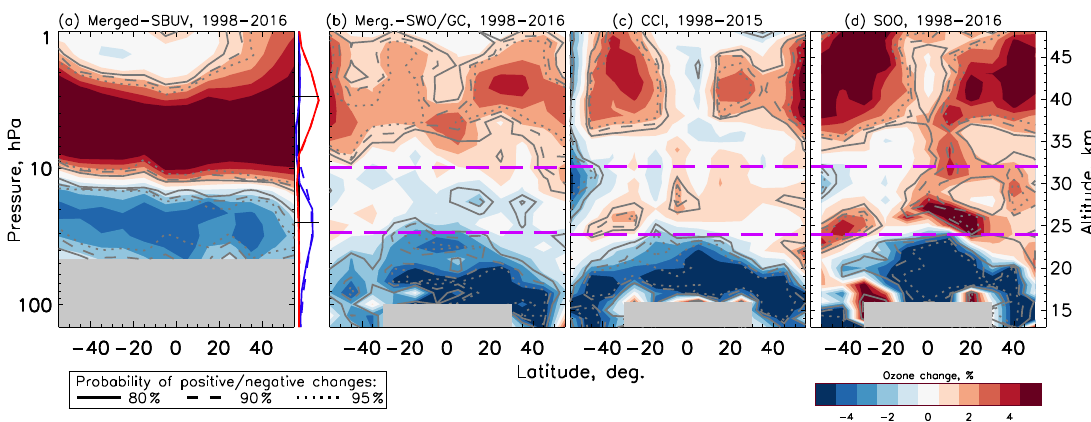
Figure 1. Zonally averaged change in ozone between 1998 and 2016. From (a–d) the Merged-SBUV, Merged-SWOOSH/GOZCARDS, SAGE-II/CCI/OMPS (CCI), and SAGE-II/OSIRIS/OMPS (SOO) composites. Red represents increases, blue decreases (%; see right legend). Contours represent probability levels of positive or negative changes (see left legend). Grey shaded regions represent unavailable data. Pink dashed lines delimit regions integrated into partial ozone columns in Fig. 2 (and Figs. S3, S4, S6, S9, and S10). To the right of Merged- SBUV are the instrument observing profiles centred at 3hPa (red, upper) and 25hPa (blue) at northern mid-latitudes (dashed) and in the tropics (solid) from Kramarova et al. (2013). SAGE-II/CCI/OMPS changes are for